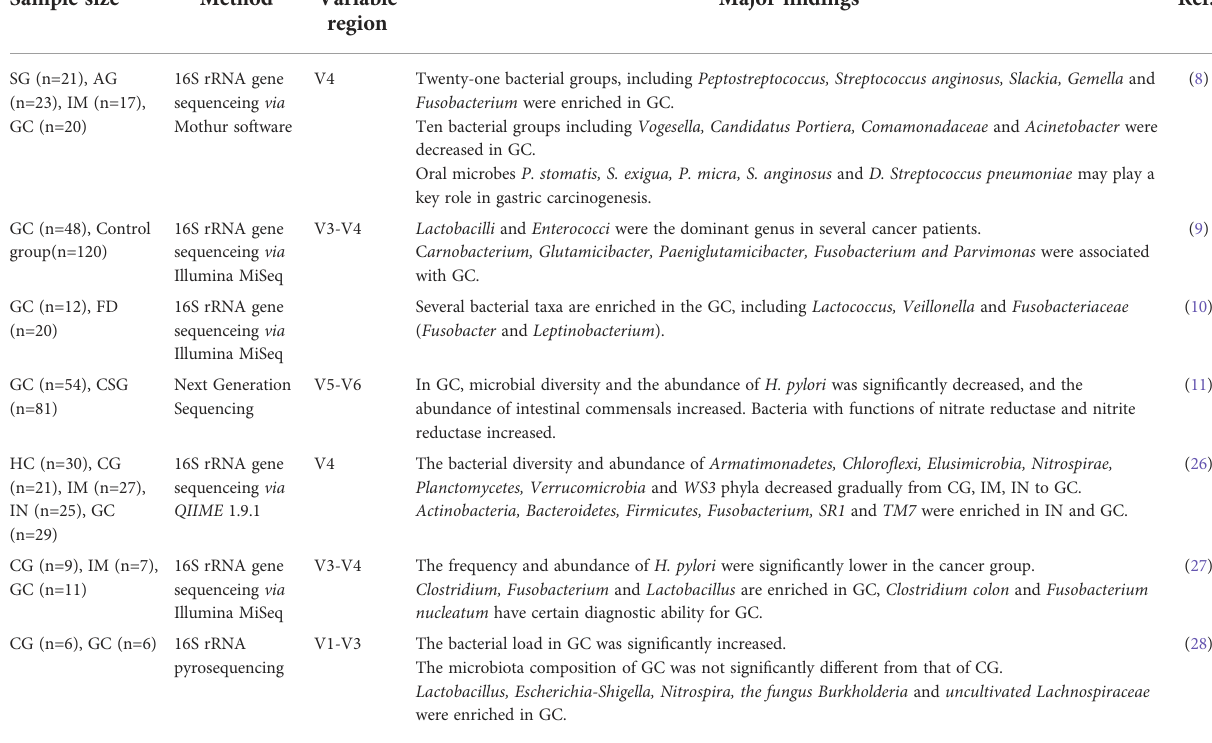
TABLE 1 Summary of studies examining the changes in microbial diversity in gastric cancer. Sample